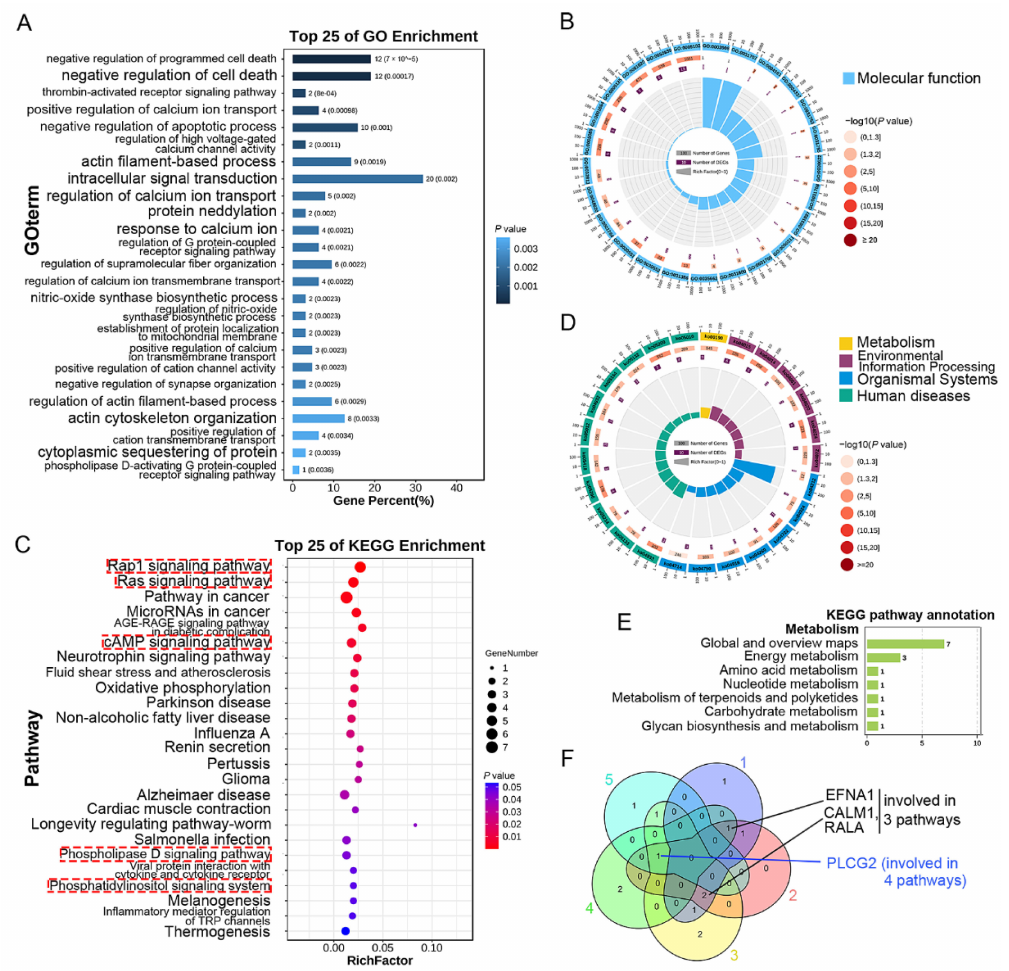
Figure 6. GO and KEGG enrichment analysis of the DEGs only expressed in the lower endothelial cells; ( A ) GO function enrichment of the DEGs only in the lower endothelial cells gradient; and ( B ) circular diagram; ( C ) KEGG pathway enrichment was showed in gradient; and ( D ) circular diagram; ( E ) KEGG pathways annotation in metabolism; ( F ) common DEGs involved in the top 5